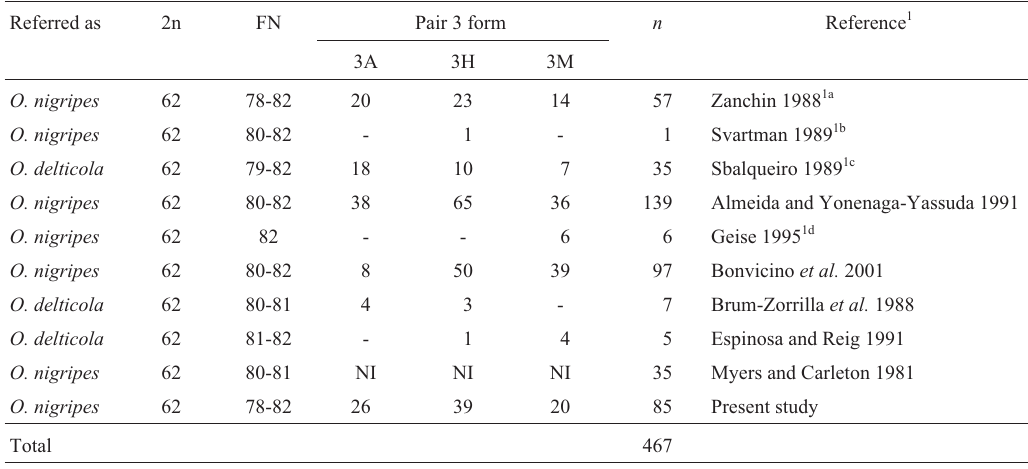
Table 2 - Constitution of pair 3 in Oligoryzomys nigripes with 2n = 62/FN = 78-82. Referred as 2n FN